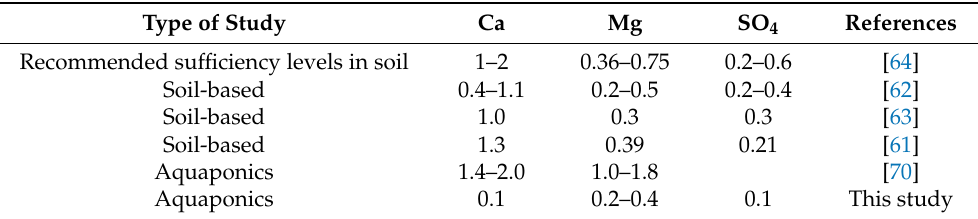
Table 7. Calcium, magnesium, and sulfur concentrations (%) in lettuce leaves in this study compared to others.